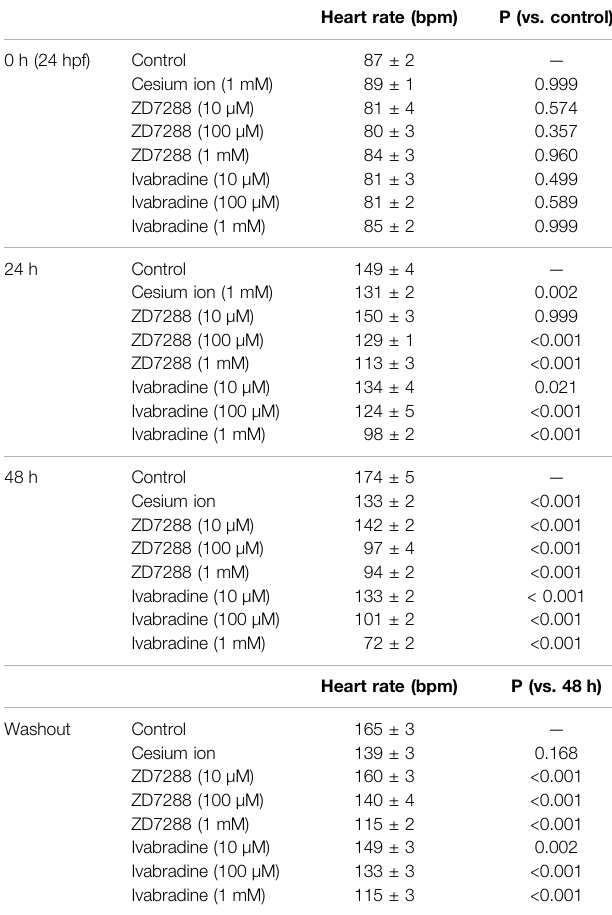
TABLE 5 | Inhibitory effects on heart rates (bpm) and p -values in developing zebra fi sh embryos. Heart rate (bpm) P (vs.